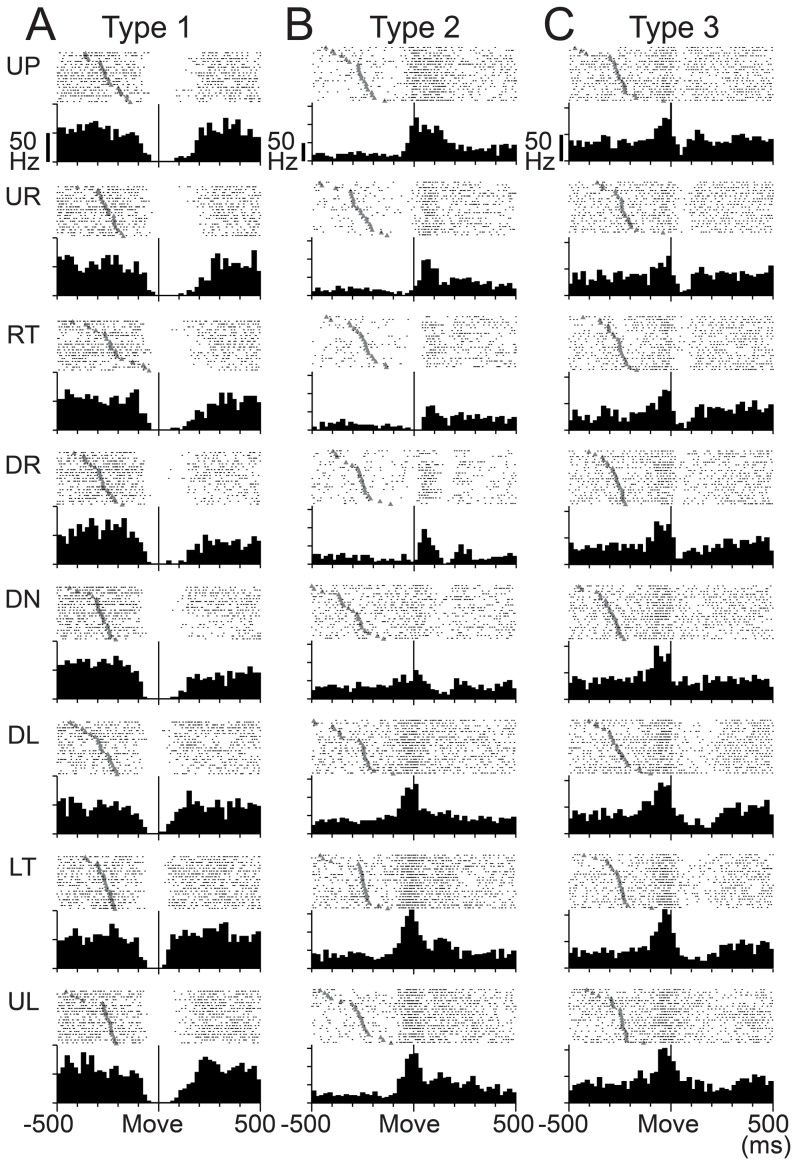
Three types of activity in wrist-movement-related DN cells.Raster plots and histograms of typical examples of three types of activity in DN cells with RFs in the distal part of the arm. Neuron activity recorded in the pronated posture is illustrated. DN cells were classified into three types based on movement-related modulations between −200 to +200 ms relative to movement onset. This figure uses the same conventions as Figure 4. A: Activity of type 1 DN cells showed suppression before movement onset. B: Activity of type 2 DN cells showed suppression before movement onset for some directions and facilitation for other directions. C: Activity of type 3 DN cells showed facilitation before movement onset. Note that the scale bars for discharge rate shown in the top row of panels differ for the three cells.